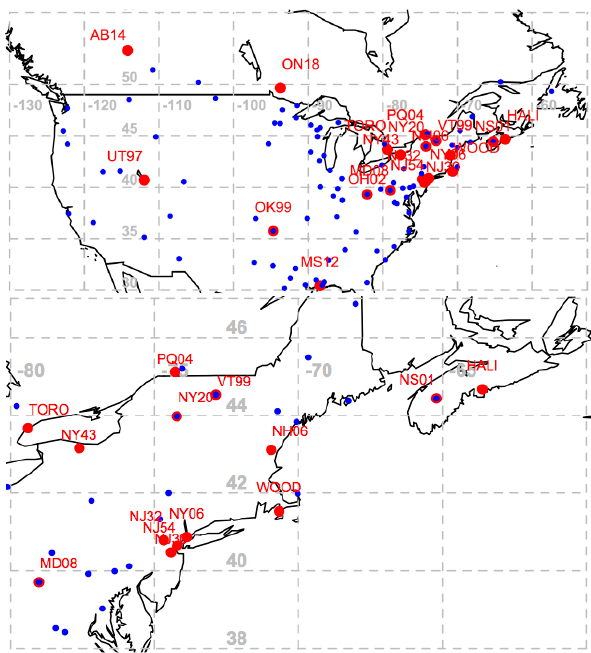
Fig. 1. (a) Location of measurement sites evaluated: oxidized mer- cury (red) and wet deposition (blue). (b) Zoomed insert shows northeastern sampling and evaluation sites resolved. Sampling sta- tion at Alert, NU, at the northern tip of Ellesmere Island not